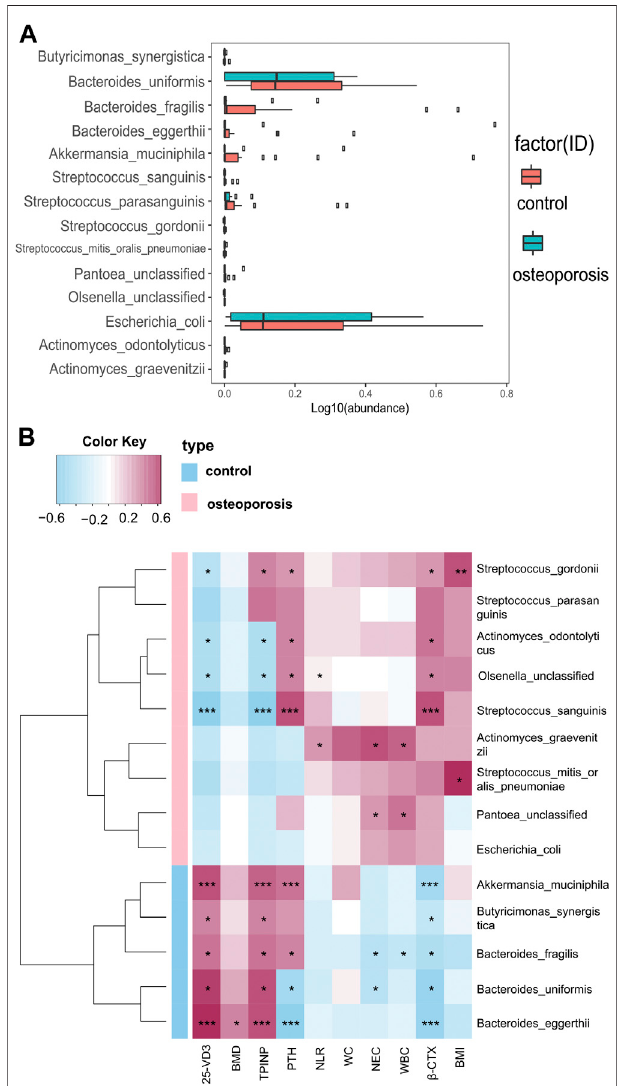
FIGURE 3 | Relative abundances of bacterial species between OP and control groups, and relationships between gut microbiota abundances and clinical indicators. (A) Wilcoxon tests were used to analyze the relative abundancesofbacterialspecies,whichshowedsigni fi cantdifferencesin 14 species with fi ve enriched in the control group and nine enriched in the OP group ( p < 0.05). (B) Correlation matrix for species and clinical parameters. Yellow and red signify a positive correlation, while blue signi fi es a negative correlation. Cells with an asterisk indicate p < 0.05.